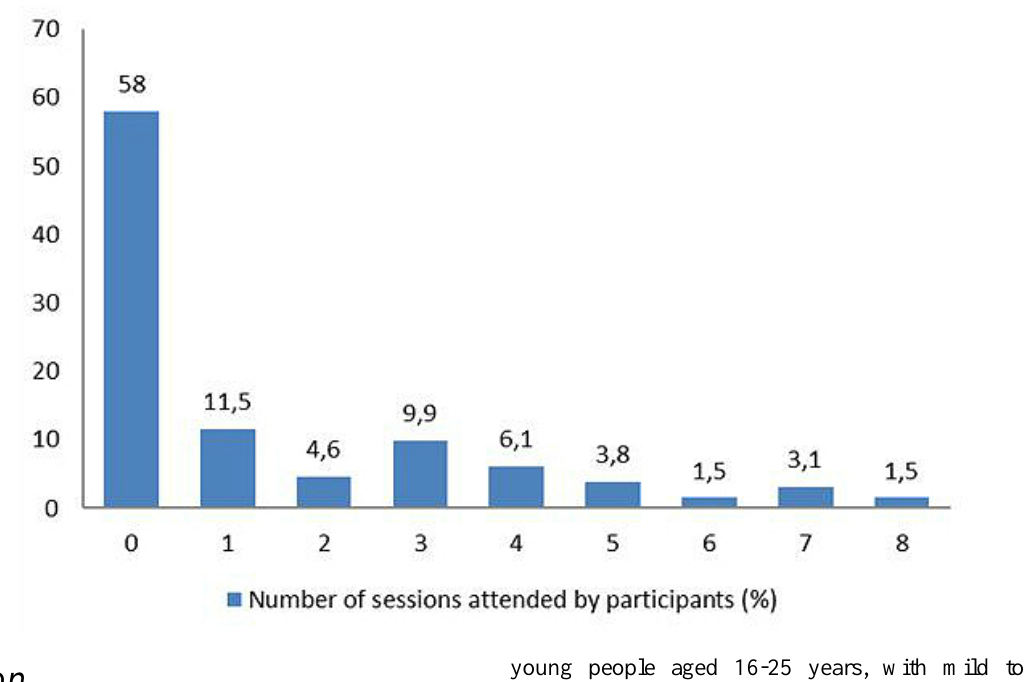
Figure 3. Number of chat sessions attended by percentages of participants